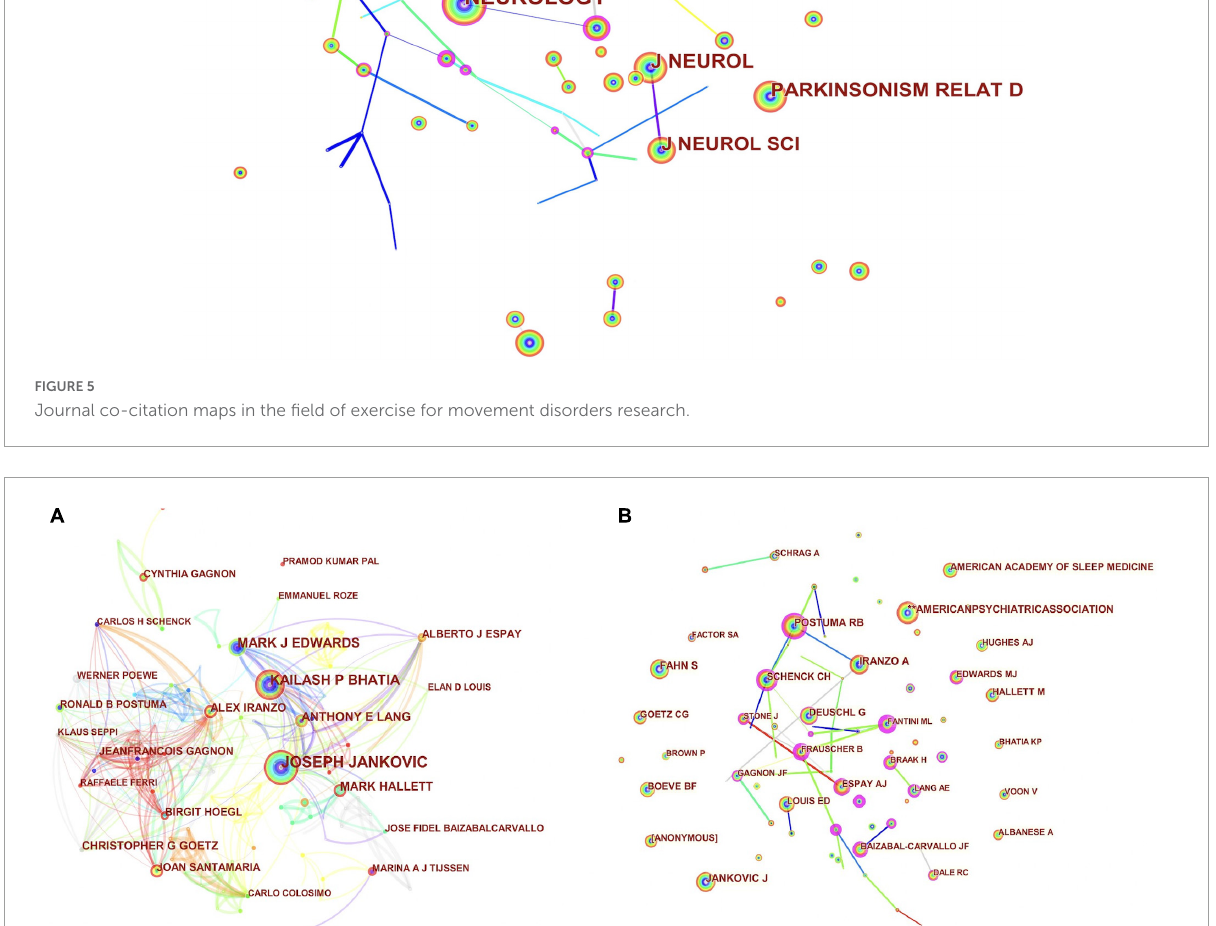
Psychology. The Neurosciences Neurology research directions accounted for 58.72% of the publication volume